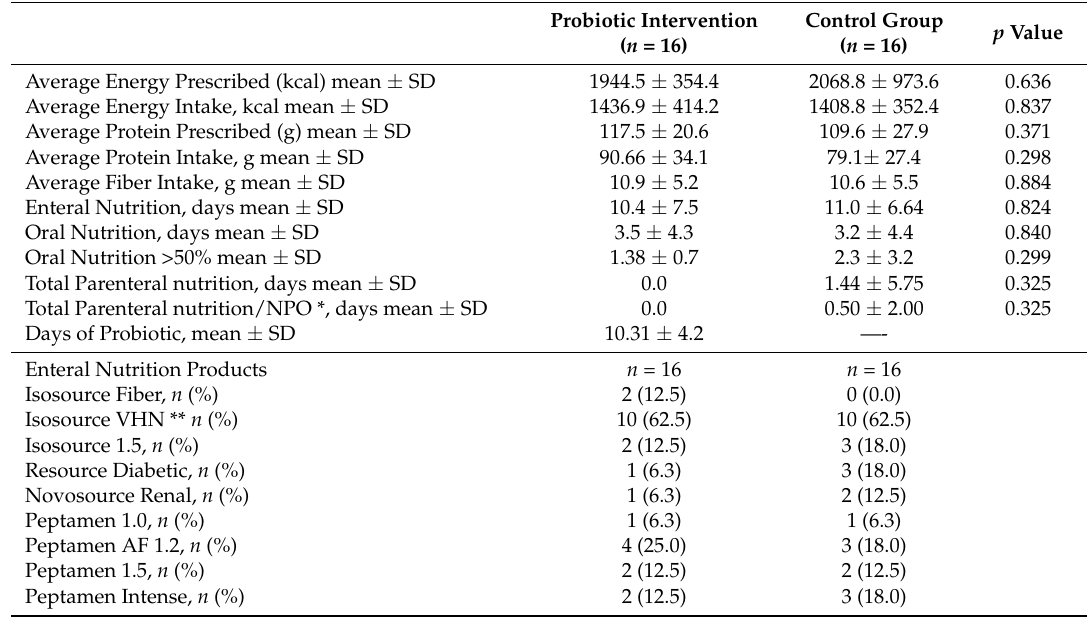
Table 4. Nutrition Data during ICU